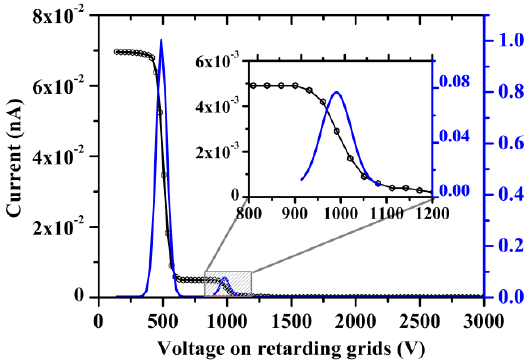
Figure 4. Example of a 3-second spectrum from the BMSW instrument. The black line shows the characteristic energy cutoff, and the blue line shows the derivative of the FC currents for protons and He ++ ions.